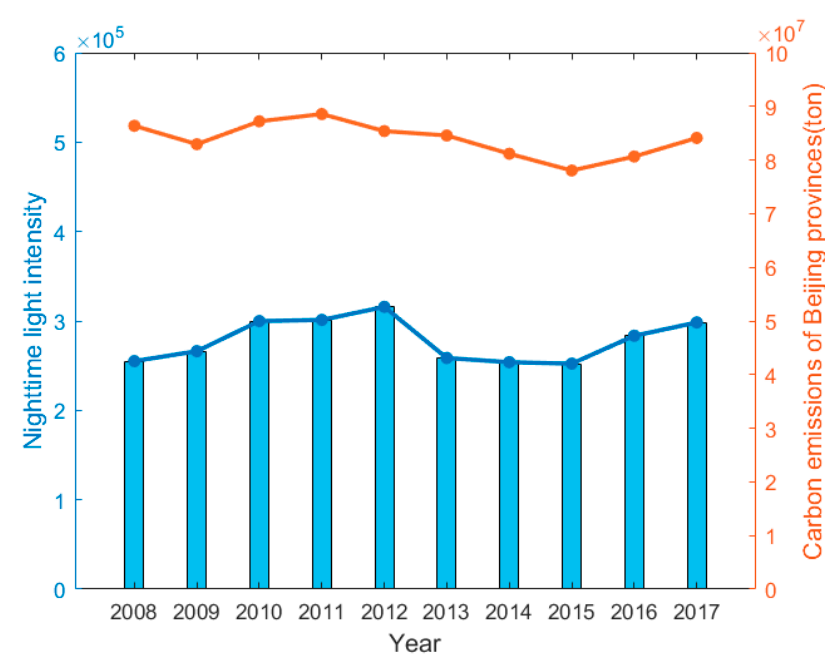
Figure 6. Total DN value of nighttime light and total carbon emissions of Beijing. Research has shown that carbon emission caused by human activities is the main reason for the increase in global CO 2 concentration. In order to control the continuous rise of CO 2 concentration, all countries in the world are committed to anthropogenic carbon emission reduction measures [30]. The change of CO 2 concentration data is taken as one of the foundations of judging the effect of emission reduction policy implementation [31]. At present, many scholars have studied the relationship between CO 2 concentration and carbon emissions. He et al. [32] found that the area with high spatial difference of near- surface CO 2 concentration was significantly correlated with human carbon emissions and was significantly affected by human activities. Diao et al. [33] found, through experiments, that CO 2 concentration was high in areas with more factories and less vegetation, and vice versa, indicating that anthropogenic carbon emissions had an important impact on CO 2 concentration. In addition, Deng et al. [34] revealed the substitution relationship between CO 2 emissions and CO 2 concentration, under the same temperature, rises by proving the substitution elasticity of CO 2 emissions and CO 2 concentration on warming. Thus, there is a positive correlation between carbon emissions and the carbon concentration. Then, we use the total carbon emissions and average CO 2 concentration data of each province in China, in 2013, to conduct a fitting to testify to the conclusion. As shown in Figure 7, the dots represent Chinese provinces. Tibet, Hong Kong, Macao, Taiwan, the Nei Monggol Autonomous Region and Heilongjiang Province were excluded from the study due to the lack of complete information. The abscissa is the total carbon emission of China’s provincial administrative divisions, and the ordinate is the average CO 2 concentration of China’s provincial administrative divisions. It can be seen from Figure 7 that most of these spots with high carbon emissions also have high average CO 2 concentration. The above conclusion can be further verified. Therefore, we theoretically speculate that there should also be a positive correlation between NL data and CO 2 data. Then, results are verified by studying the night-light remote sensing images and the spatial distribution map of CO 2 concentration in each